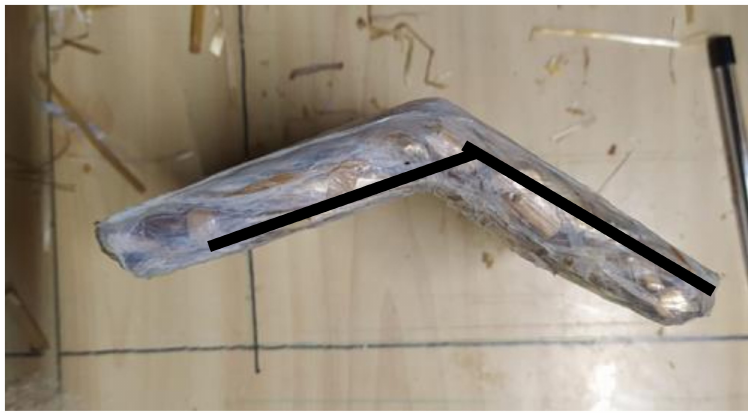
Figure 9. Bending results with pre-heating conditions.